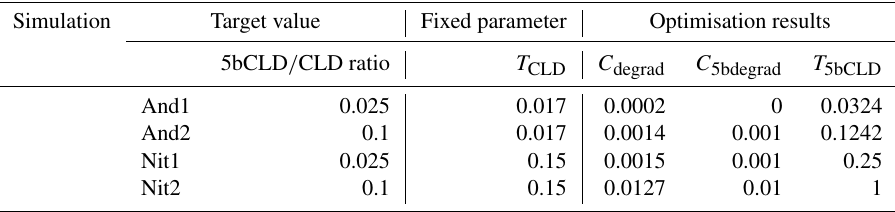
Table 2. Parameters of four simulation scenarios for CLD and 5b CLD fate. CLD and 5bCLD degradation rate ( C degrad C 5bdegrad ) and 5bCLD lixiviation rate ( T 5bCLD ) stemmed from optimisation processes based on two target values of the 5bCLD / CLD ratio in leaching water (cases 1 and 2), as well as two hypotheses for the CLD ( T CLD ) lixiviation rate (fixed parameter) corresponding to andosol type (And) and nitisol type